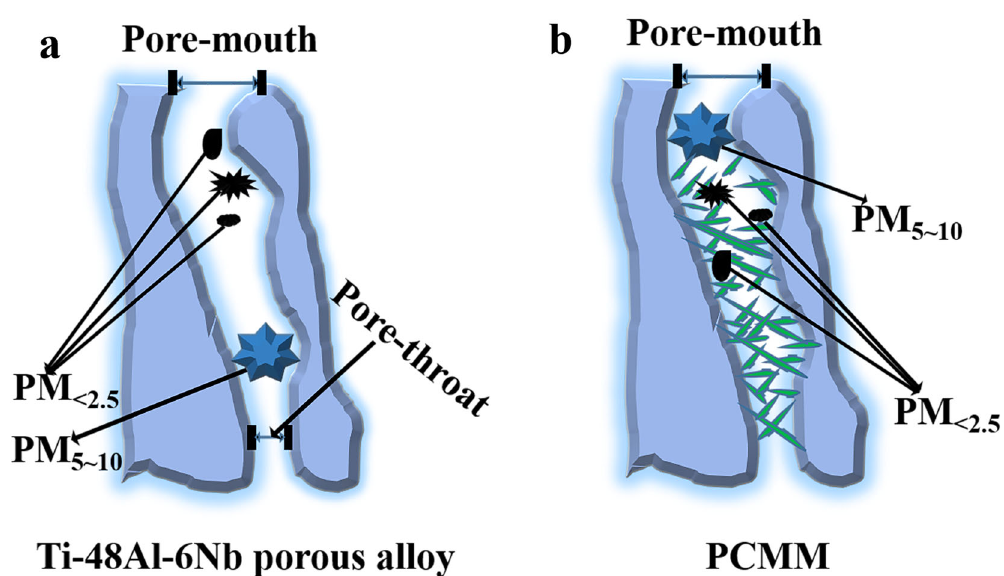
Fig. 11 Schematic illustration of PM removal mechanism for as-prepared porous sample. a Ti-48Al-6Nb porous alloy; b PCMM.